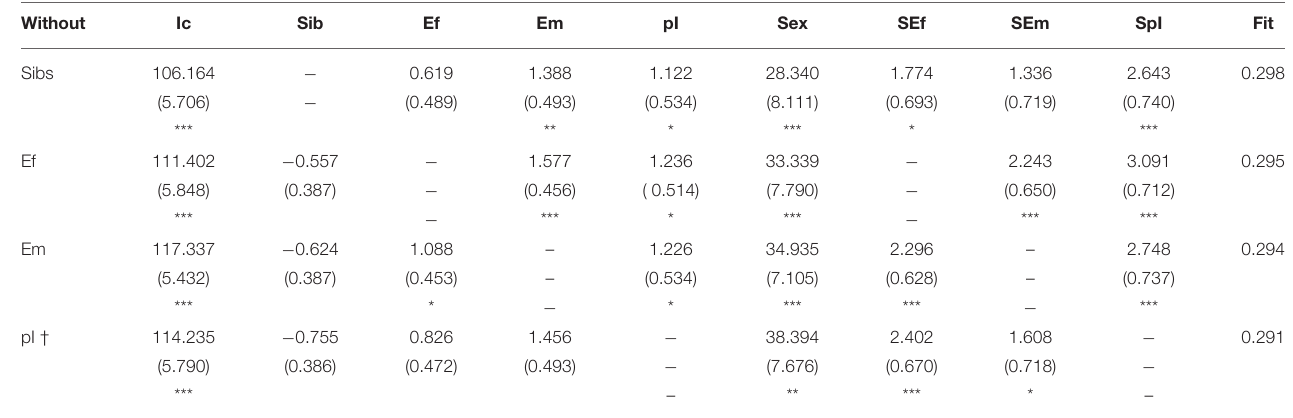
TABLE 3 | Effects of omitting independent variables on our income†